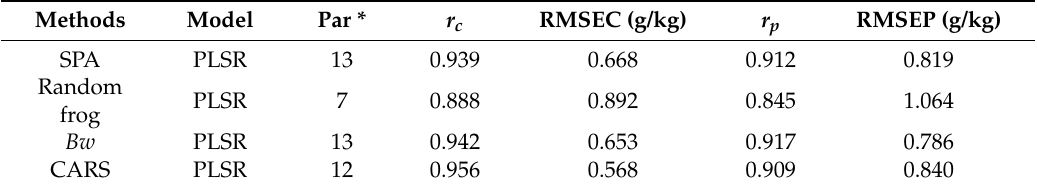
Table 3. Results of PLSR models using optimal wavelengths selected by four different methods.